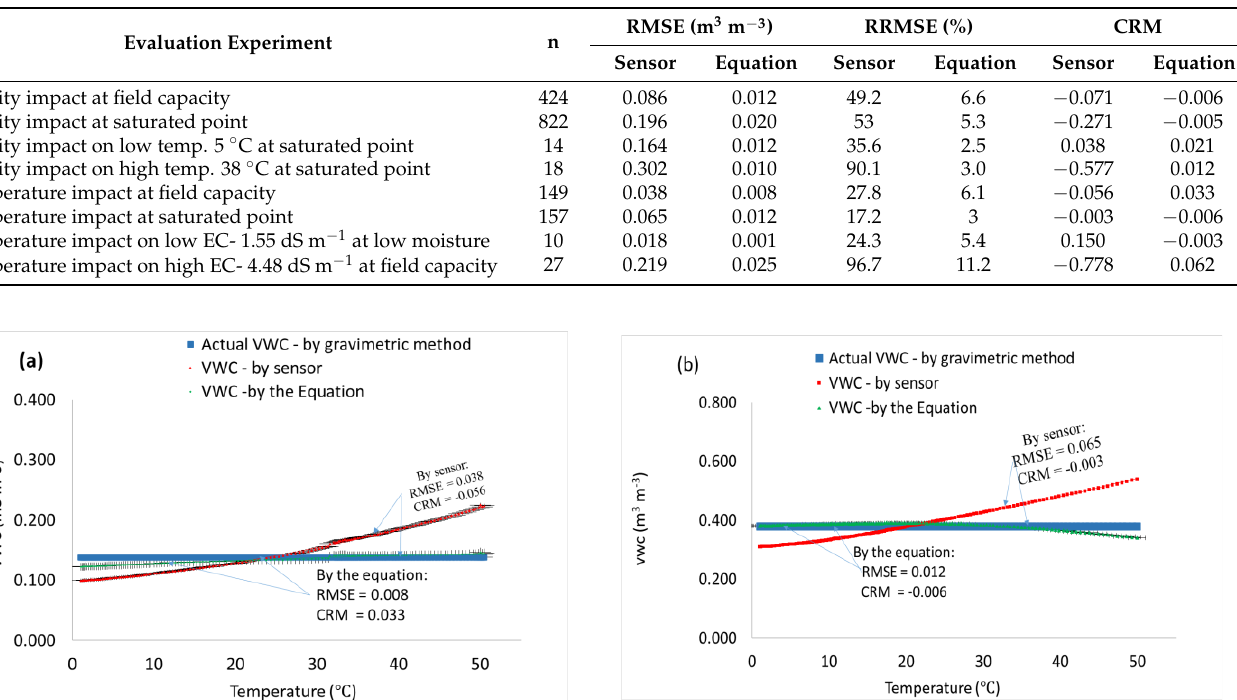
Figure 12. Comparison between VWC values measured by sensors using gravimetric method and proposed L&O correction equation with gradual increase in soil salinity at ( a ) 5 °C and ( b ) 38 °C.